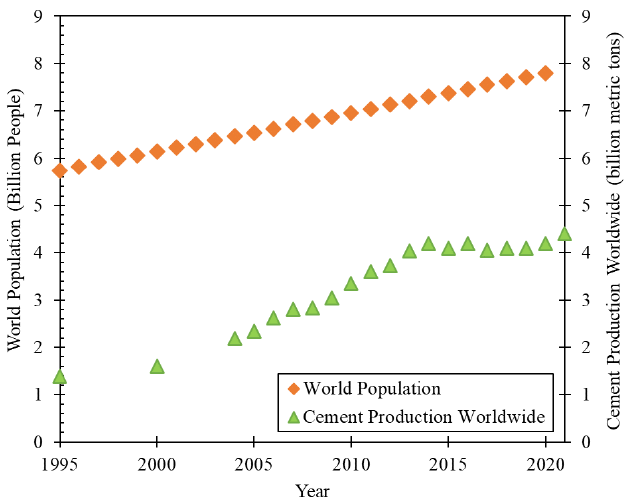
Figure 1. World population (data source [10]) and cement production worldwide (data source [11,12]).